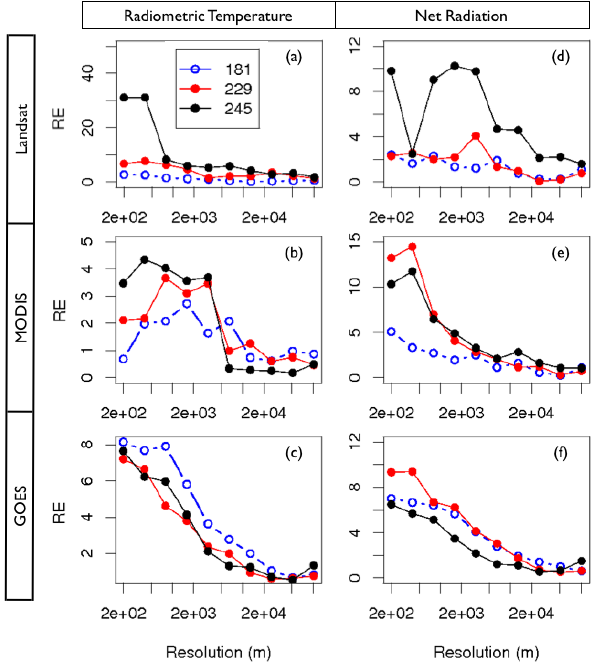
Fig. 5. Multiresolution entropy computed from low-pass (left) and band-pass (right) wavelet reconstructions for each sensor (rows) and each day (lines).